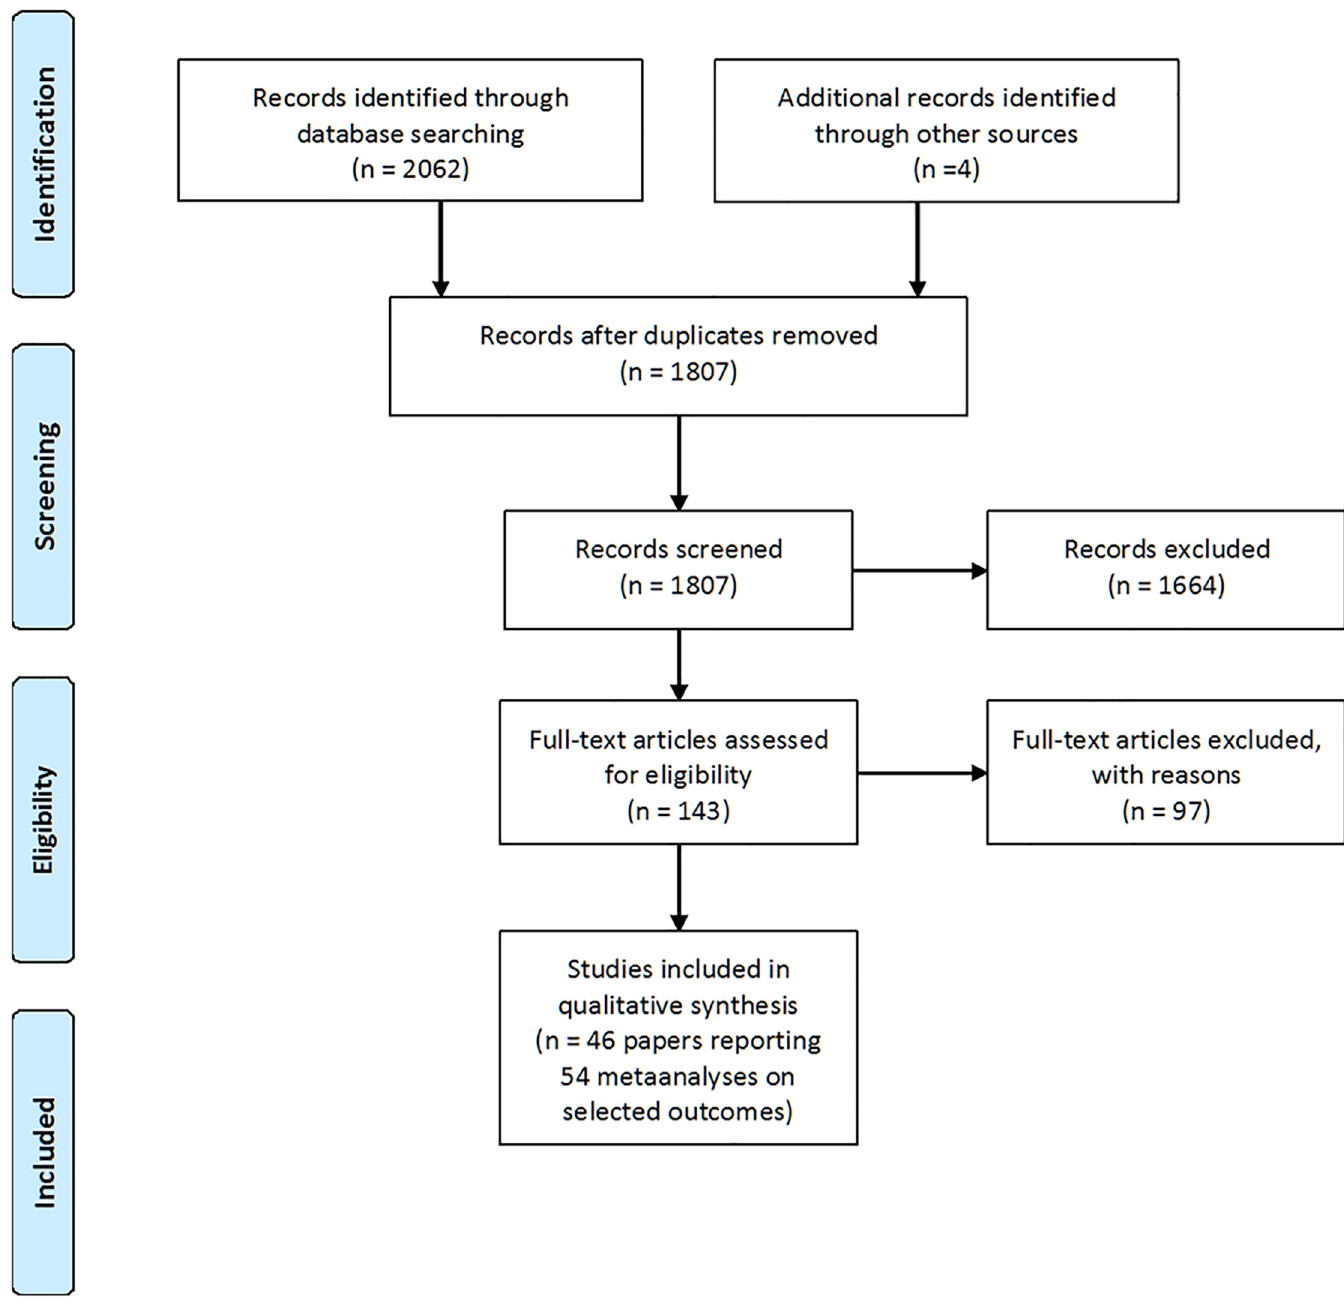
Fig 1. PRISMA flow